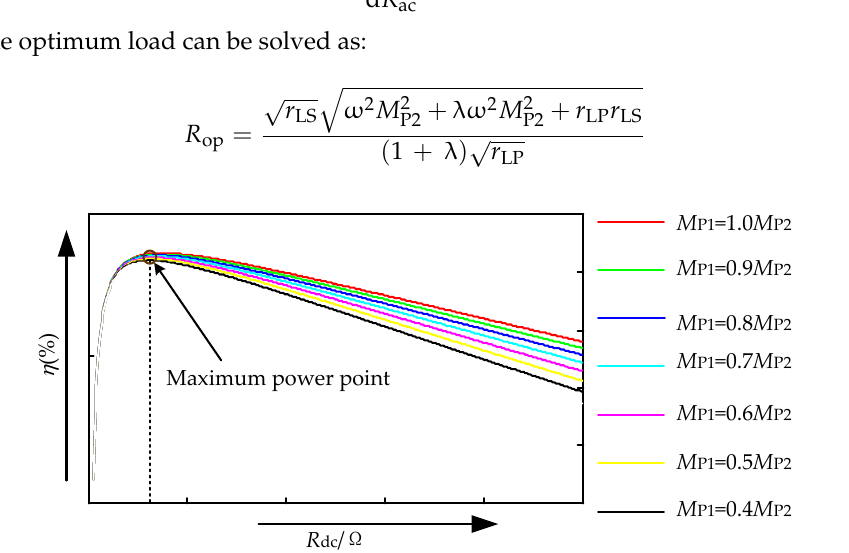
Figure 6. The efficiency of the IPT system versus the load.